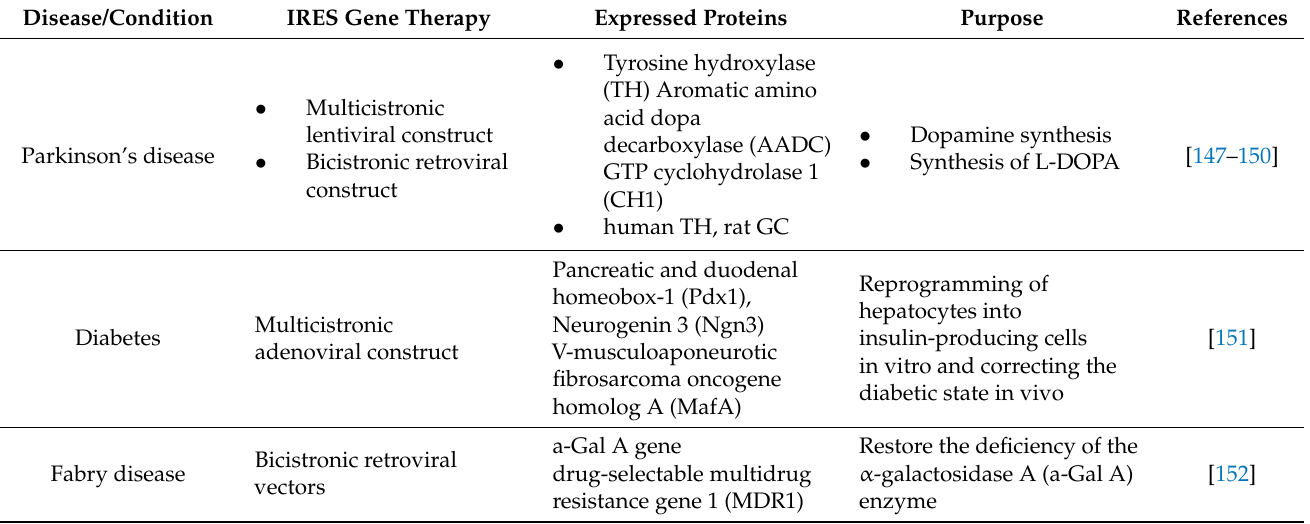
Table 2. Summary of diseases/conditions that benefit from the use of IRES-based multicistronic vectors co-expressing different proteins to restore the expression levels of proteins required to resume the wild-type